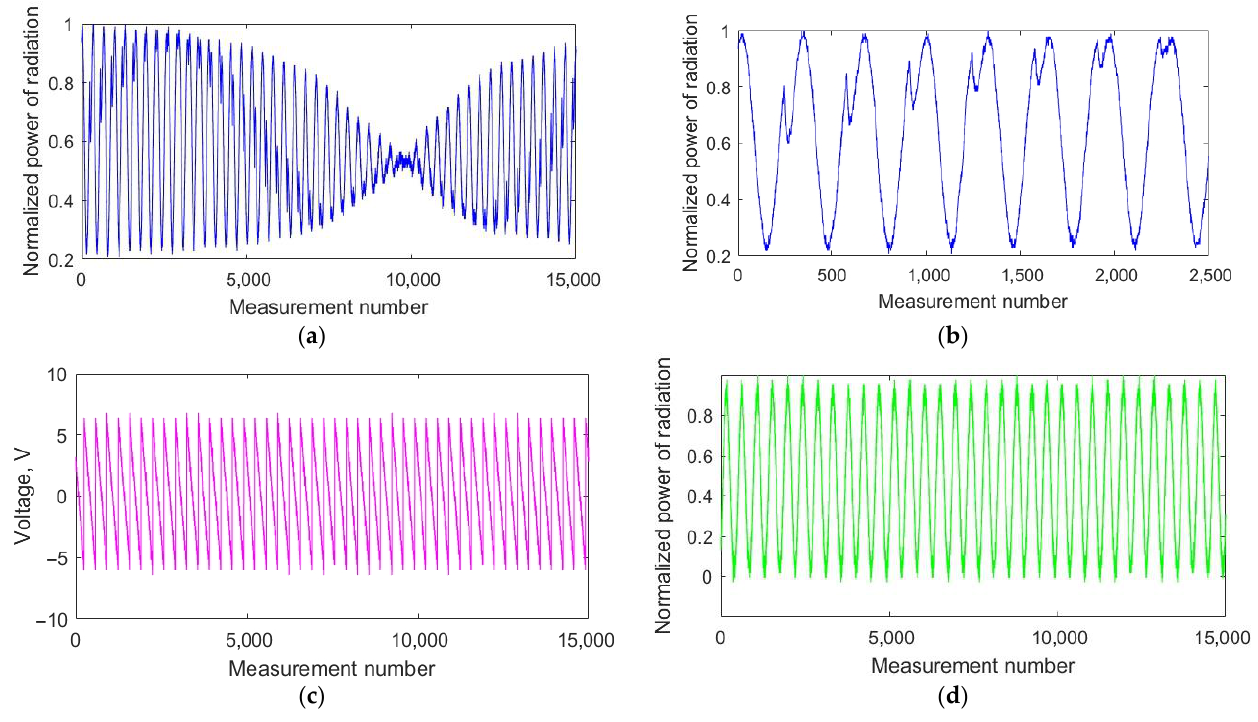
Figure 7. Signals fed to the oscilloscope: ( a , b ) Normalized signal from the photodetector, 11; ( c ) Signal from the sawtooth generator, 17; ( d ) Normalized signal from the photodetector,